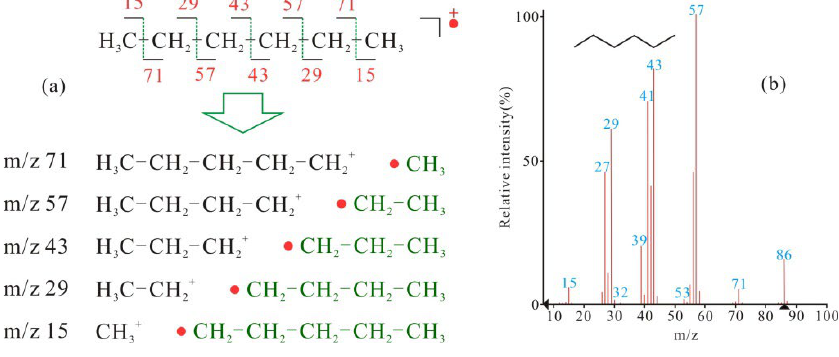
Figure 1. Ionization diagram ( a ) and mass spectrum ( b ) of n -hexane.